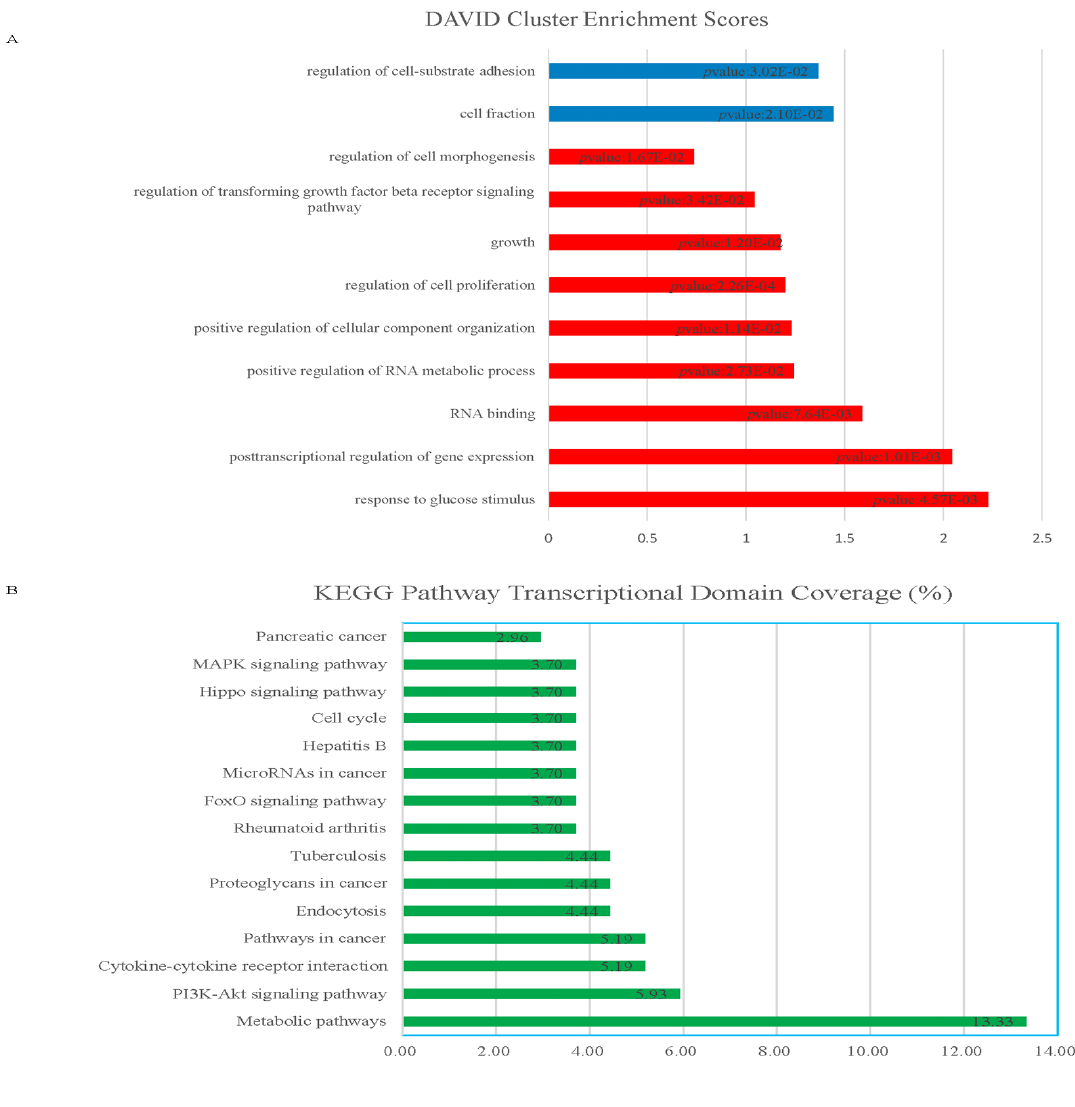
Figure 2. Bioinformatics analysis of HOTAIR loss in Bel-7402 HCC cell line. ( A ) Gene ontology analysis of HOTAIR knockdown microarray data using the DAVID program. Red bars represent the top hits for upregulated genes. Blue bars represent the top hits for downregulated genes. DAVID enrichment scores are represented with Benjamini-Hochberg-adjusted p values. All error bars in this figure are mean ± S.E.M.; ( B ) KEGG pathway analysis of HOTAIR knockdown microarray data. Green bars represent the percentage of transcriptional domain coverage; and ( C ) mRNA-signaling pathway integrated network based on the predicted interactions